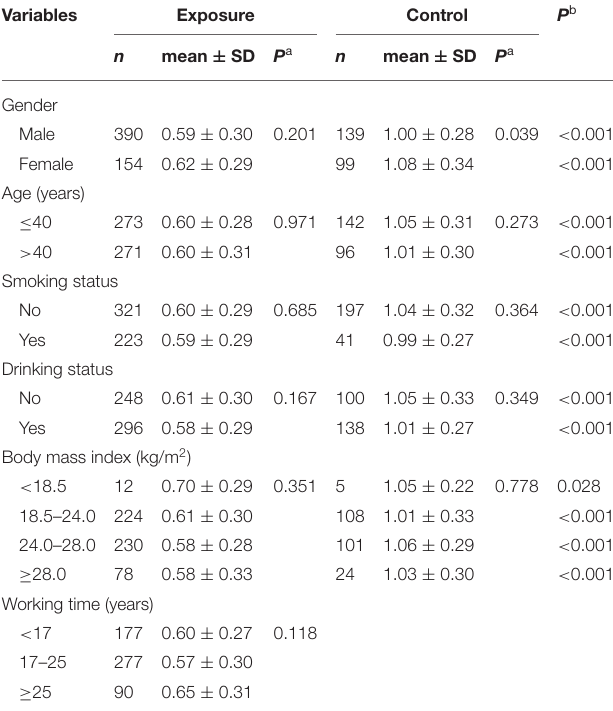
TABLE 2 | MtDNA copy number by individual